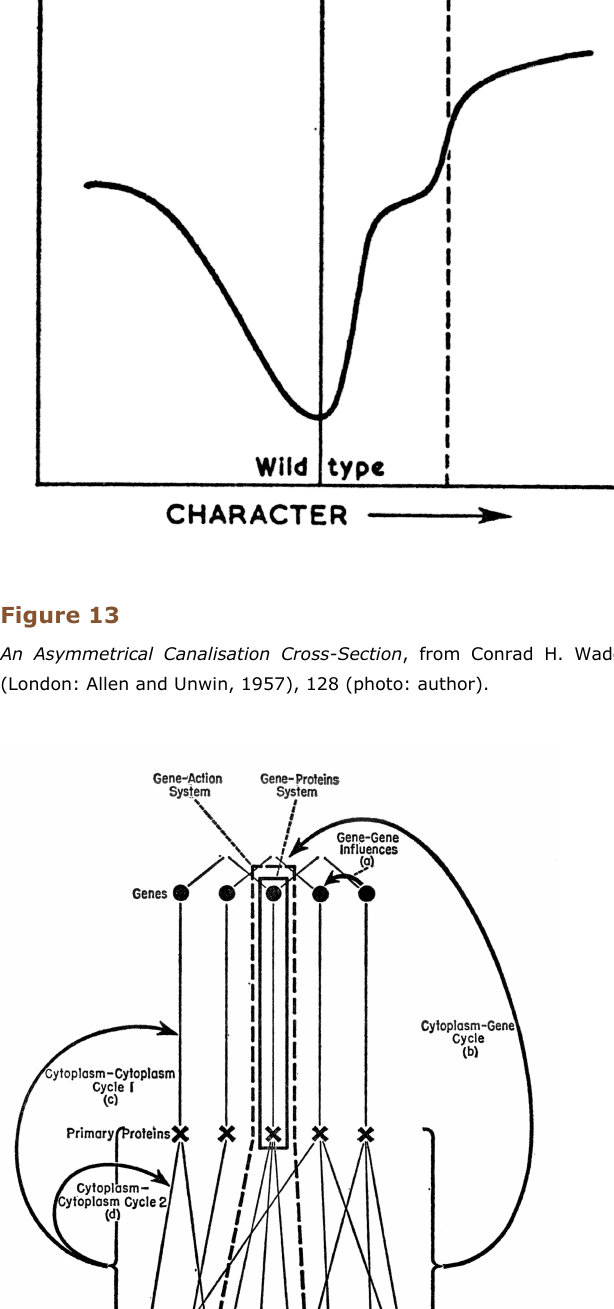
Contemporaneity: Historical Presence in Visual Culture http://contemporaneity.pitt.edu Vol 4, No 1 (2015) | ISSN 2155-1162 (online) | DOI 10.5195/contemp.2015.143